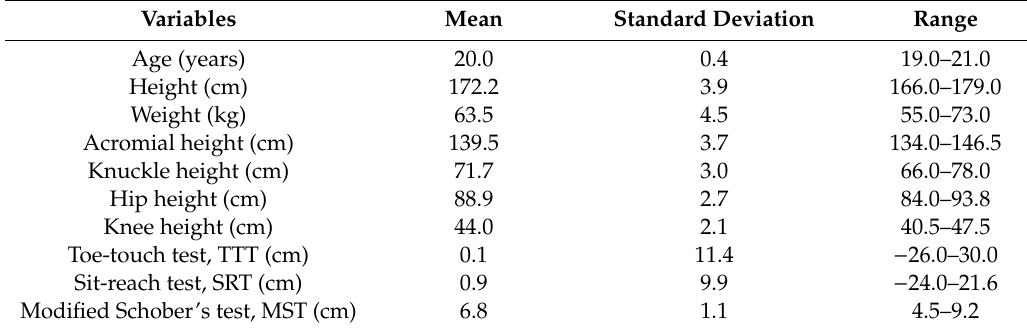
Table 1. Anthropometric data and the flexibility values of participants in the study.